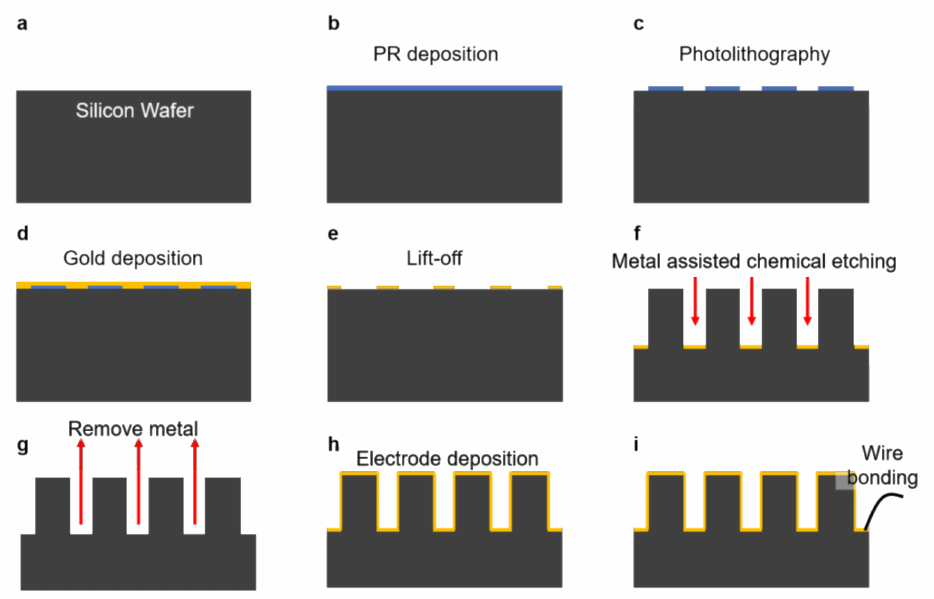
Figure 2. Fabrication process of micro-pillar (MP) electrode based on metal-assisted chemical (MAC)